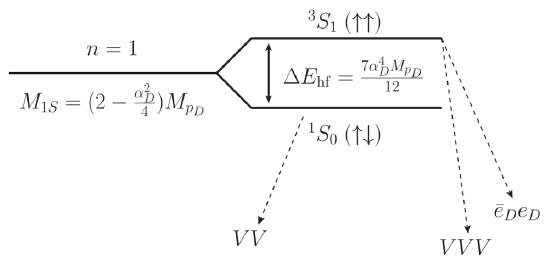
p Figure 3: Diagramatic summary of the ¯ p DM bound state decays, analogous to D D those of true muonium [ 59 ] . Bound state formation becomes important at relatively large values of α and M and when the temperature drops far enough for the p D D inverse ionization process to become slower than the relevant decay